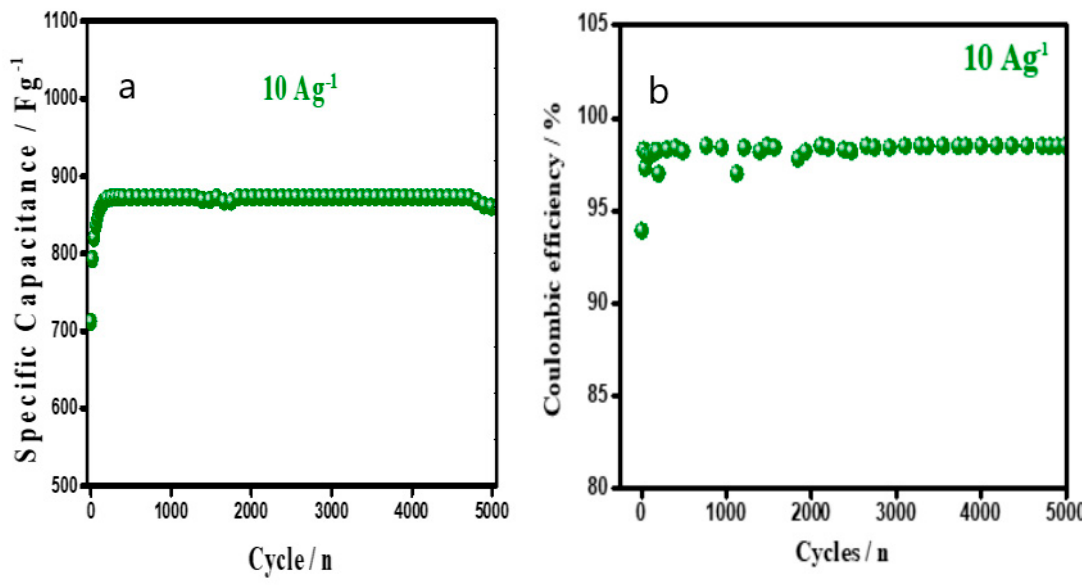
Figure 15. Variation of ( a ) specific capacitance and ( b ) coulombic efficiency of a P – DBSA ║ P – DBSA device, with a continuous cycling life at 10 Ag − 1 .